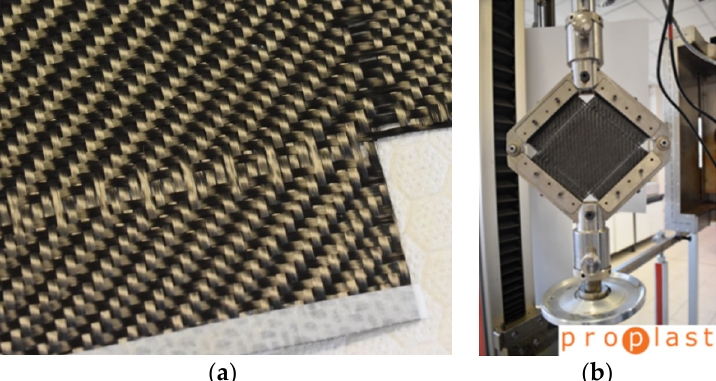
Figure 5. Detail of CF Specimen ( a ) and experimental setup ( b ) for Shear test on Dry fabric for Intra-ply evaluation.